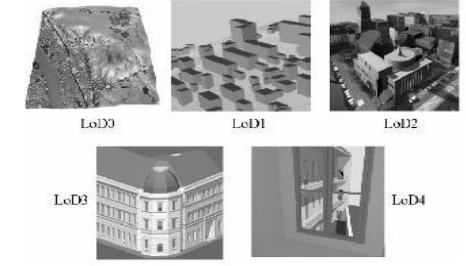
Fig.18. Lavels of Detail (LoD) defined by CityGML CityGML provides a model at multiple levels of generalisation. These can be used individually within a model or multiple levels of representation can be modelled together. The levels